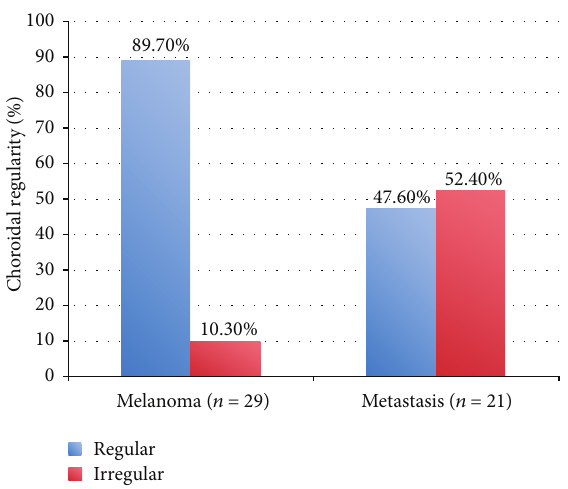
Figure 4: Choroidal regularity. Almost 90% of the malignant choroidal melanomas had a regular choroidal surface compared with about one-half of the choroidal